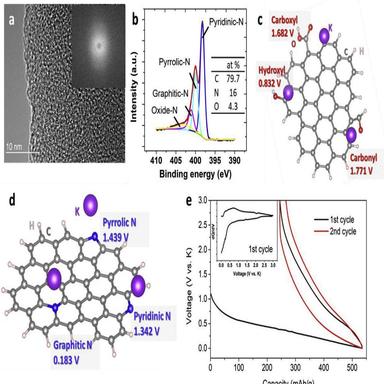
(a) TEM image of CNF-650 (inset showing the FFT image); (b) Deconvoluted N1s spectra for CNF-650; Calculation results of adsorption energy of potassium ion on (c) oxygenated functional groups and (d) N-doped graphene; (e) Voltage profile of CNF-650 at the current density of 25 mA/g, inset is the dQ/dV plot. (A colour version of this figure can be viewed online.)